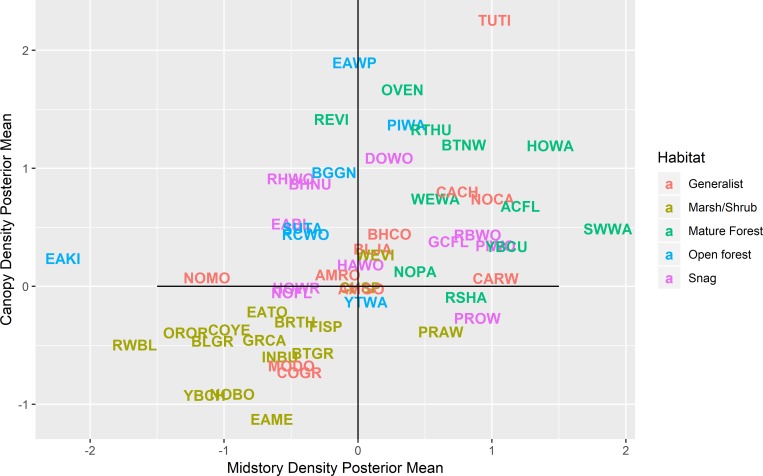
Posterior means for the effects of forest canopy and midstory vegetation density on occupancy of 56 species of birds detected in coastal forests of eastern North Carolina, USA between 2013 and 2015.The farther above/below or left/right of the zero lines (solid lines), represent a stronger response to canopy density and midstory density, respectively. Codes for bird species are located according to the magnitude and direction of the corresponding posterior means and are colored according to known habitat associations (generalist = multiple habitat associations, marsh/shrub = low statured vegetation, mature forest = closed canopy forest, open forest = open canopy forest, snag = standing dead trees). Common and scientific names of birds are in Table 1.